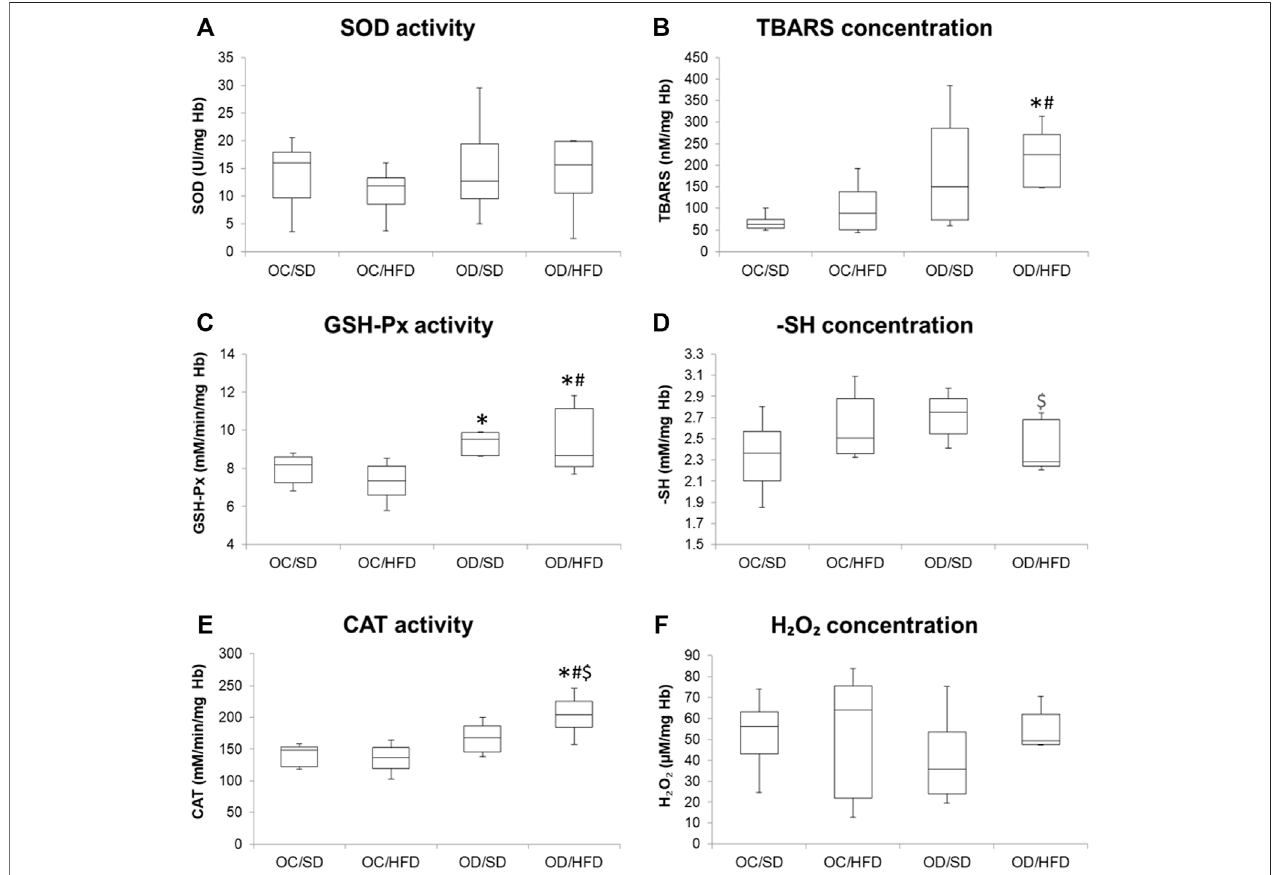
FIGURE 3 | (A) SOD,superoxidedismutaseactivity; (B) TBARS,tiobarbituricacidreagentspeciesconcentration; (C) GSH-Px,glutathioneperoxidaseactivity; (D) reduced thiol groups concentration (-SH) (E) CAT, catalase activity; and (F) hydrogen peroxide concentration (H 2 O 2 ) in washed erythrocytes at full-term pregnancy from OC, control offspring; and OD, diabeticoffspring that received aSD, standard diet or HFD, high-fat diet; from weaning. Values are expressed asmean ± SD, standard deviation; n = 10rats/ group.* p < 0.05 — comparedtotheOC/SDgroup;# p < 0.05 — comparedtotheOC/HFDgroup;$ p < 0.05 — comparedtotheOD/SDgroup(TukeyMultipleComparison